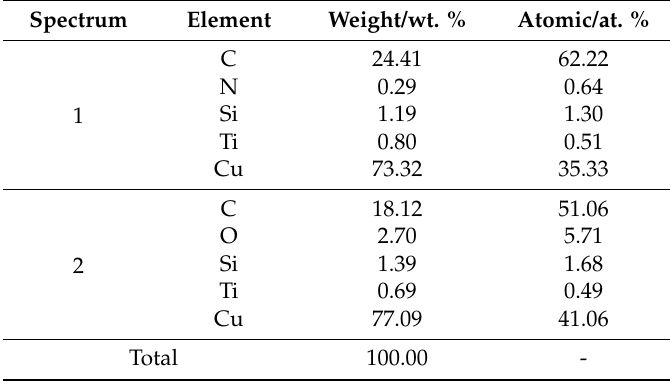
Table 3. EDS patterns of spectra 1,2 in Figure 9e,f, respectively. Spectrum